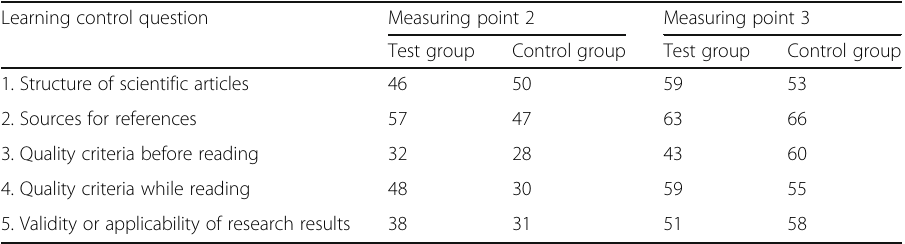
Table 2 Comparison of the average coverage of the concepts of the model resolution in student responses to learning control questions between the test and control groups